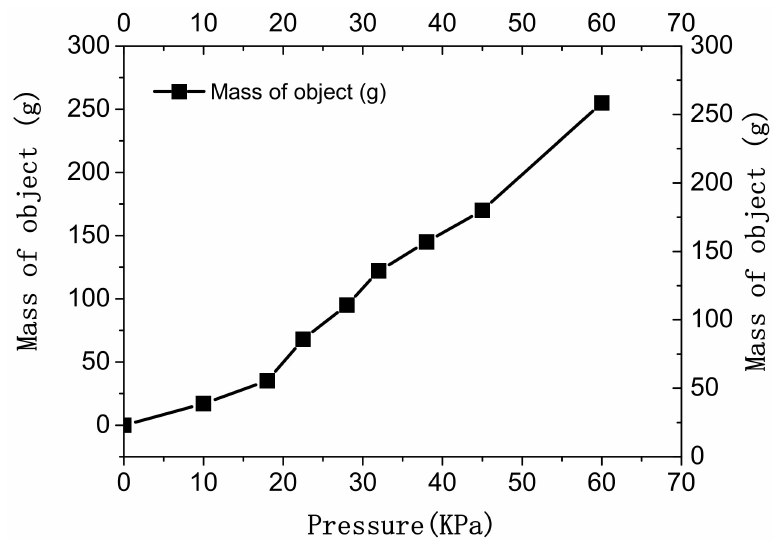
Figure 18. The relationship diagram between air pressure and grasping object